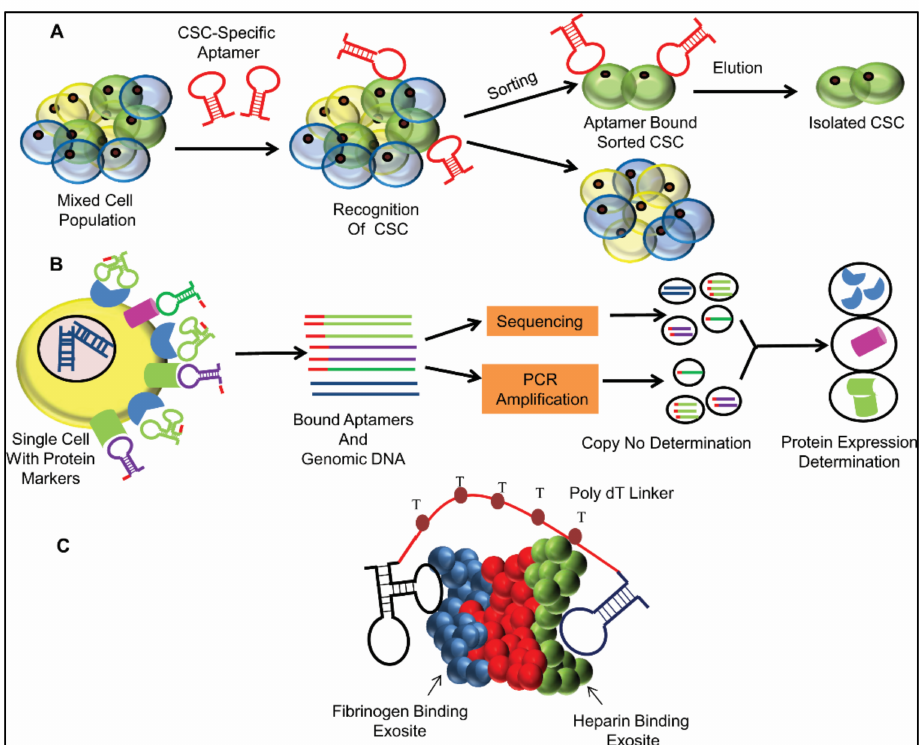
Figure 5. Schematic representation of the Future applications of aptamers: ( A ) Aptamer-mediated cancer stem cell isolation: In the tumor site, there is a mixed cell population. The CSC-specific aptamer can only bind to the particular CSC marker against which it is generated. Aptamer-bound CSCs are distinguished from the heterogeneous population. ( B ) Role of aptamers in Single Cell Proteomics: Unique sequence-tagged aptamers bind with different protein targets present on a single cell. Targeted Single cell sequencing determines the copy number of each of the bound aptamers, which, in turn, provide the expression level of the corresponding proteins or the nature of scProteomics. ( C ) Aptamer dimerization via a linker: Two different aptamers bind with a thrombin protein at two different domains, i.e., the fibrinogen-binding site (blue) and heparin-binding site (green), respectively, and are connected by various lengths of a poly dT linker, among which the five-thymine linker is the most suitable